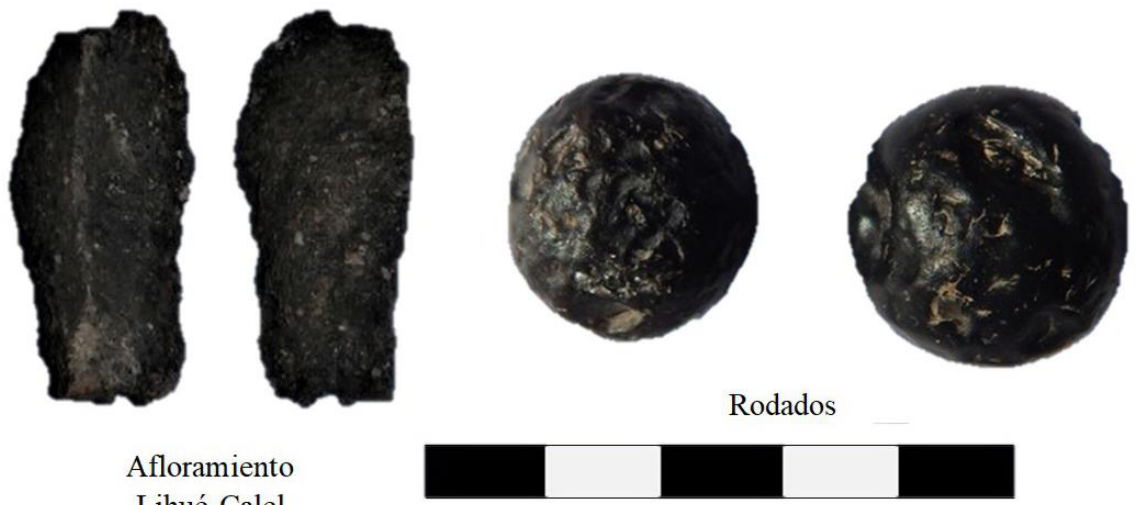
Figure 8. Obsidian sample from Lihué Calel hills and obsidian nodules from Curacó basin area. Scale bar = 5 cm (1 cm